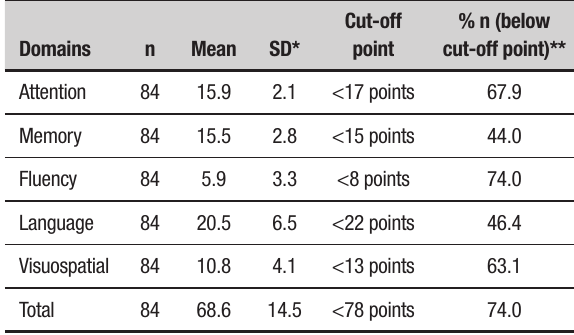
Table 2. ACE-R descriptive data, by